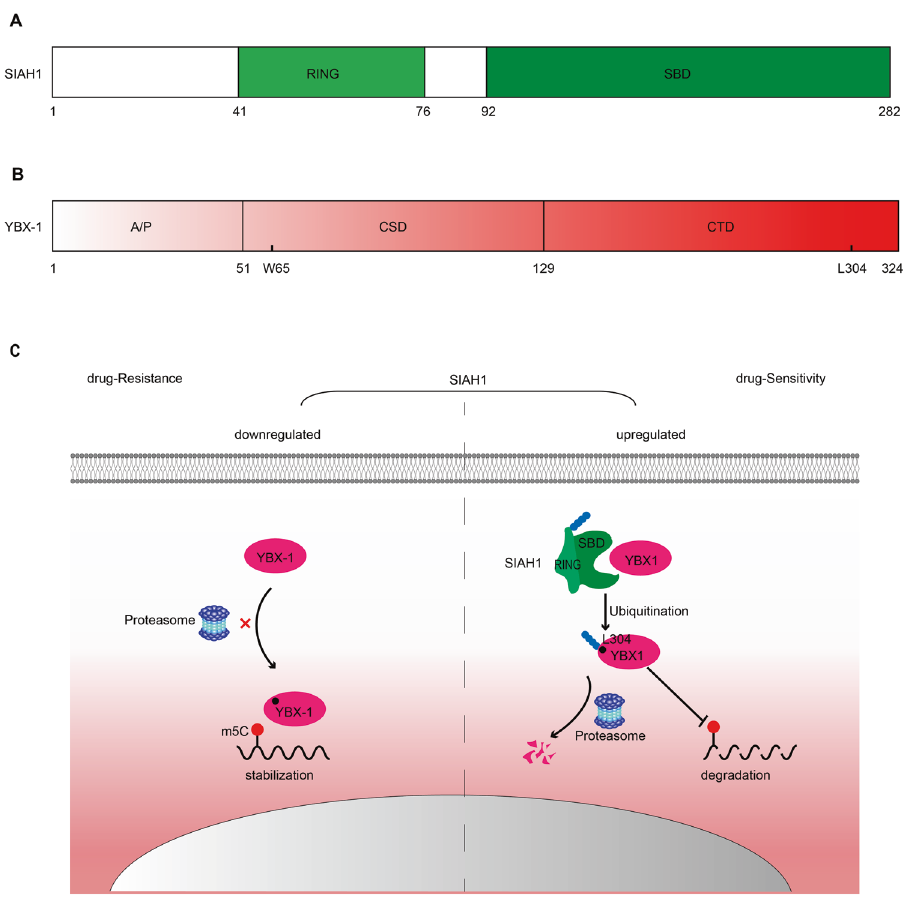
Fig. 1 The secondary structure of proteins and a diagrammatic sketch of the protective effects of SIAH1 in EOC by reversing drug resistance. A Schematic of the structure of the SIAH1 protein. The relative positions of the catalytic RING domain and a substrate-binding domain cold shock domain (CSD). B Domain organization of YBX-1 proteins. Relative positions of the amino acid residues CTD are shown. AP- domain: alanine/proline-rich domain, CDS: cold shock domain, and Lysine 304 ubiquitination site is indicated throughout the 324AA long protein structure. C Model: SIAH1, promoting YBX-1 ubiquitylation and proteasome degradation to regulate the stability of the mRNA E2F5, YY1, and RCC2, ultimately leading to a platinum-sensitive EOC